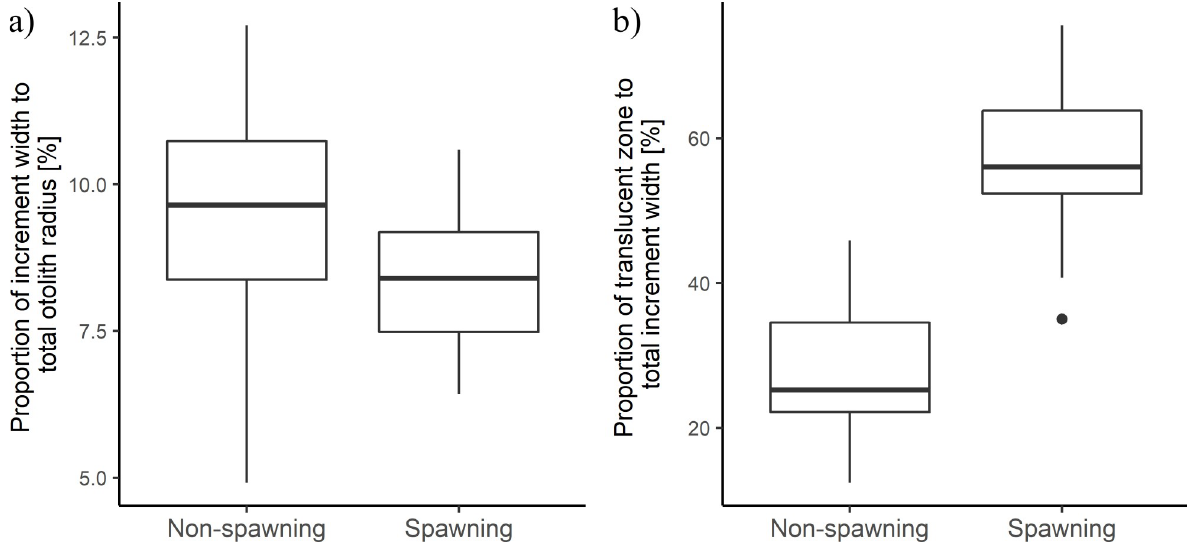
Fig 2. Comparison of width of increments formed at the same age and identified as either non-spawning or spawning zones. An age-verified subsample of 8-years old NEA cod otoliths was used for the comparison.